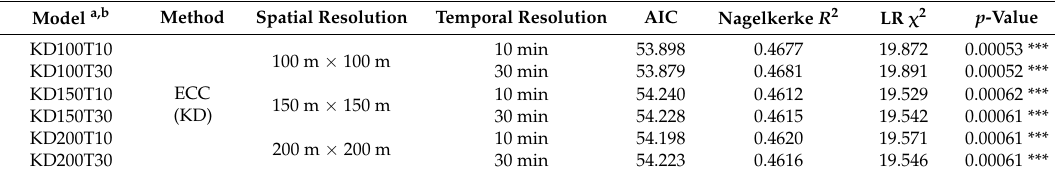
Table A2. The results of binary logistic regression models with different measurements of individual BMI-unhealthy food environment exposure for relationships between food environment exposure and overweight